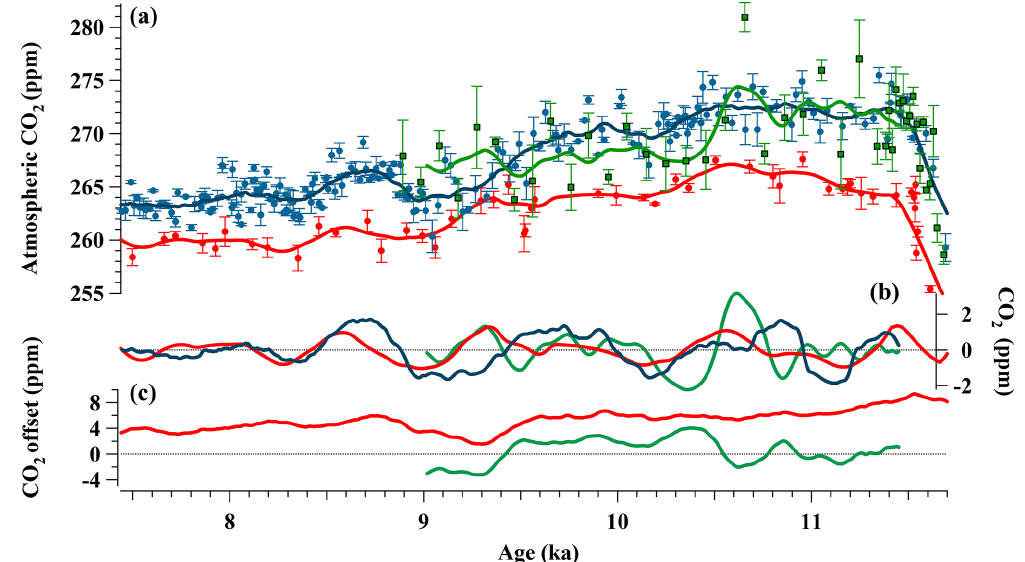
Figure 2. (a) Atmospheric CO 2 records. Red dots: atmospheric CO 2 record from Dome C ice core. Red line: 250-year running means of atmospheric CO 2 record from Dome C ice core. Blue dots: atmospheric CO 2 record from Siple Dome ice core. Blue line: 250-year running means of atmospheric CO 2 record from Siple Dome ice core. Green dots: atmospheric CO 2 record from WAIS Divide ice core. Green line: 250-year running means of atmospheric CO 2 record from WAIS Divide ice core. (b) The blue line indicates 250-year running means of the original Siple Dome CO 2 data processed by high-pass filtering at 1 / 1800yr − 1 . The green line indicates 250-year running means of the original WAIS Divide CO 2 data processed by high-pass filtering at 1 / 1800yr − 1 . The red line indicates 250-year running means of the original WAIS Divide CO 2 data processed by high-pass filtering at 1 / 1800yr − 1 . (c) CO 2 offset between Siple Dome CO 2 record and other published CO 2 records. Red line: CO 2 offset between Siple Dome CO 2 record and Dome C CO 2 record. Green line: CO 2 offset between Siple Dome CO 2 record and WAIS Divide CO 2